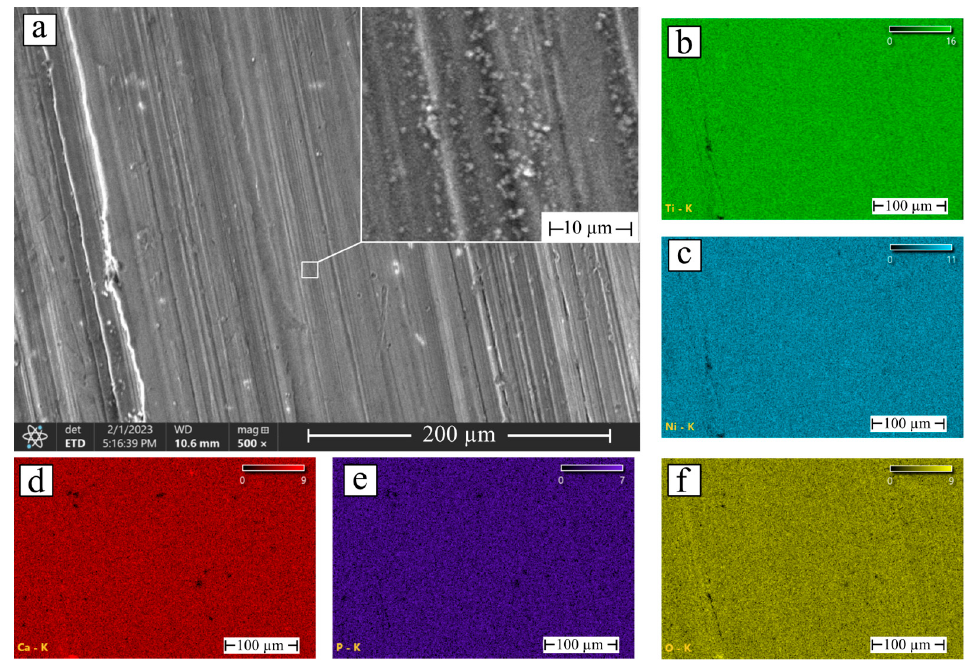
Figure 3. ( a ) SEM image of the NiTi with hydroxyapatite coating deposited for 2 h and elemental maps of: ( b ) Ti; ( c ) Ni; ( d ) Ca; ( e ) P; and ( f ) O.